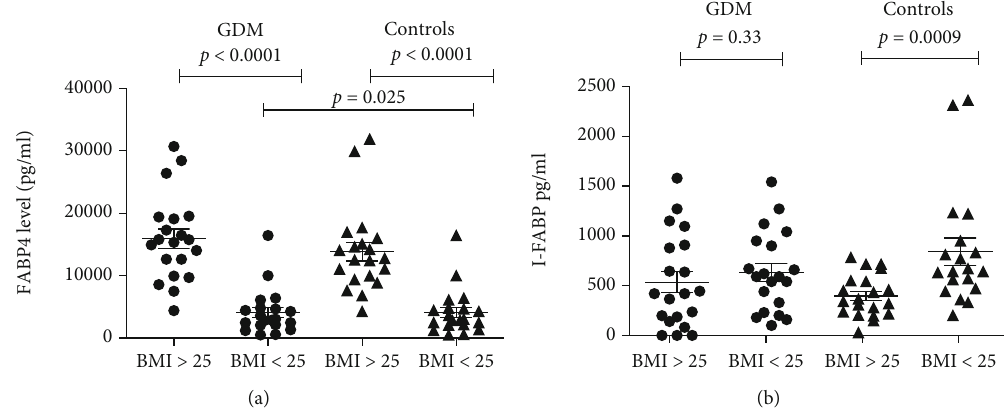
Figure 1: (a) Comparison of FABP4 level in GDM women and in controls based on BMI. In the GDM group BMI > 25 vs. BMI < 25 (15530 (10601-19309) vs. 2930 (2060-4750) pg/ml) ( p < 0 : 0001 ). In controls, BMI > 25 vs. BMI < 25 (12613 (9497-15726) vs. 5730 (3155-9425) pg/ml) ( p < 0 : 0001 ). GDM vs. controls with BMI < 25 ( p = 0 : 025 ). Every dot represents the value of FABP4 in pg/ml for one